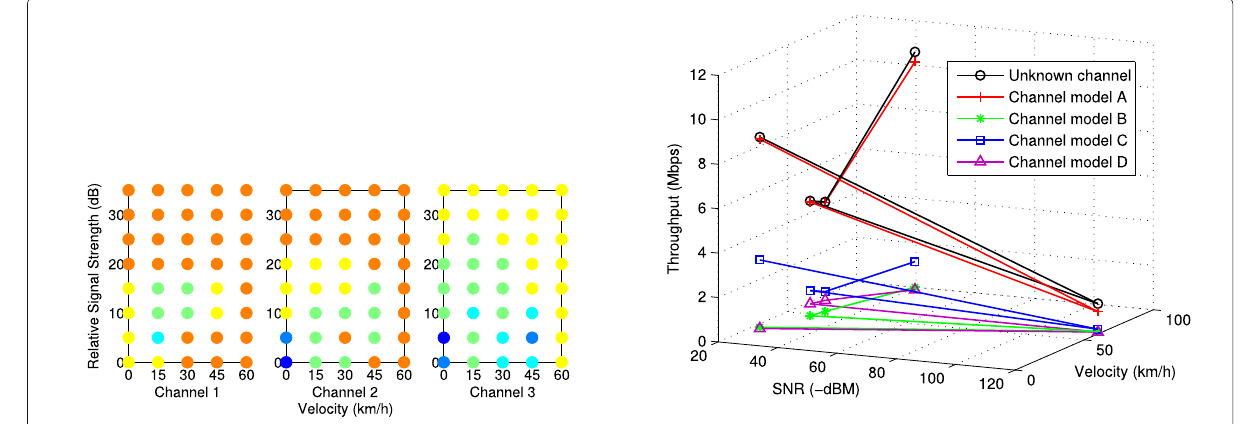
Fig. 3 Throughput performance comparison of transmission modes. a The transmission mode with highest throughput in the context space. Dots of the same color represent that the context share the common optimal transmission mode. b The variance of the throughput performance with the SNR and velocity for 4 known channels and an unknown channel